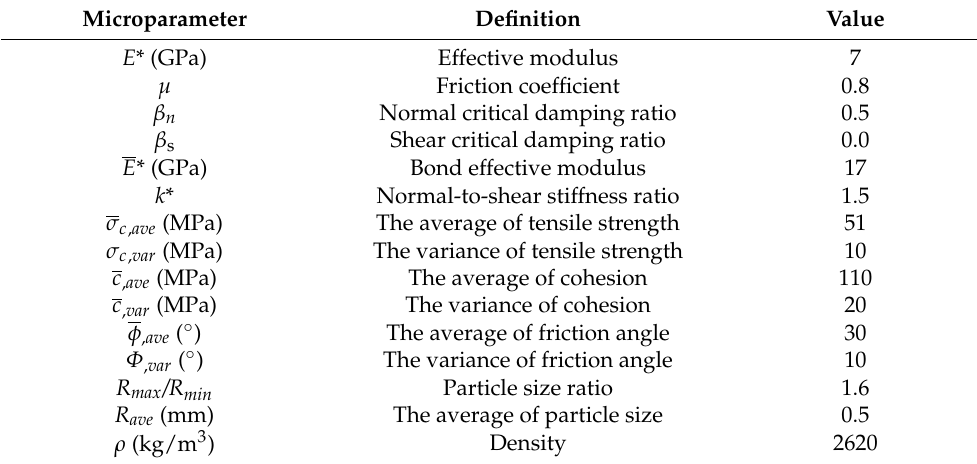
Table 1. Microparameters of the contact bond model and parallel bond model.